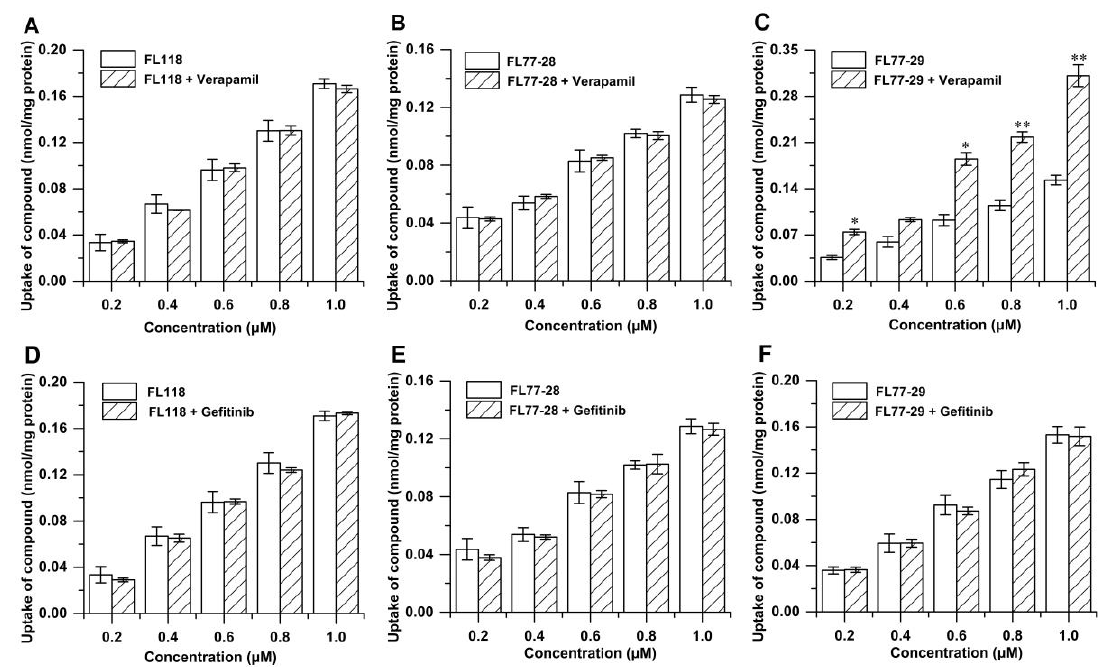
Figure 5. The uptake of FL118, FL77-28 and FL77-29 (0.2, 0.4, 0.6, 0.8, or 1.0 µ M) in Caco-2 cell in the presence or absence of P-gp inhibitor-Verapamil ( A , C , E ) and BCRP inhibitor-Gefitinib ( B , D , F ) for 4 h at 37 ◦ C. Results are shown as the mean ± SD ( n = 3). * indicated p < 0.05 and ** indicated p < 0.01, compared with the control group.